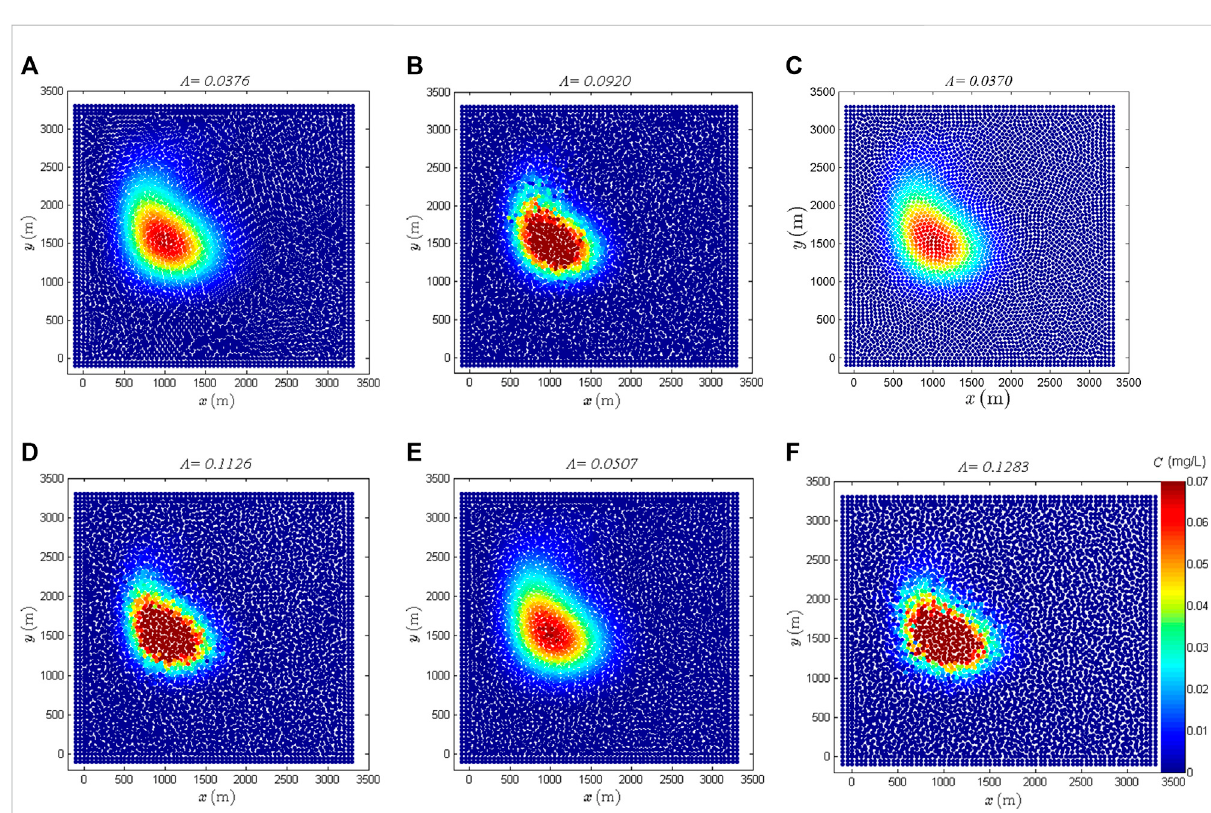
FIGURE 12 SimulationresultsofSPHcombinedwithLind ’ sPSTwithRFindifferentsmoothinglengthanddifferent L p . (A) h =1.1 dx and L p =0.5, (B) h =1.1 dx and L p = 1, (C) h = 1.33 dx and L p = 1, (D) h = 1.33 dx and L p = 1.6, (E) h = 1.5 dx and L p = 1.6 and (F) h = 1.5 dx and L p =